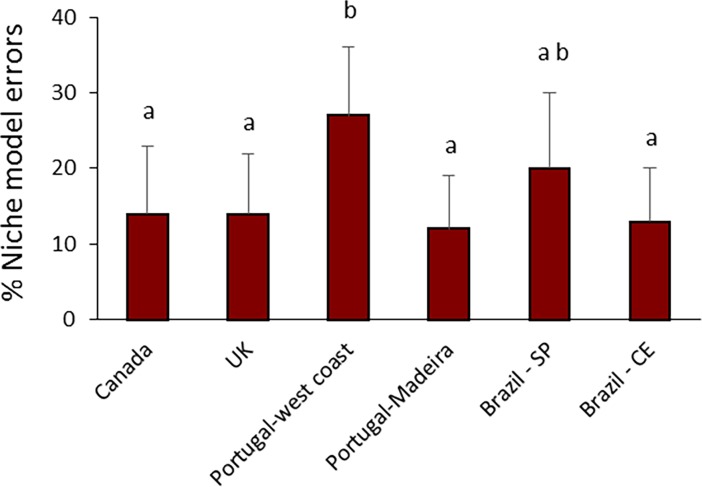
Percentage of niche model errors for 18 network structure properties (defined in Table 3) that are greater than |1|.